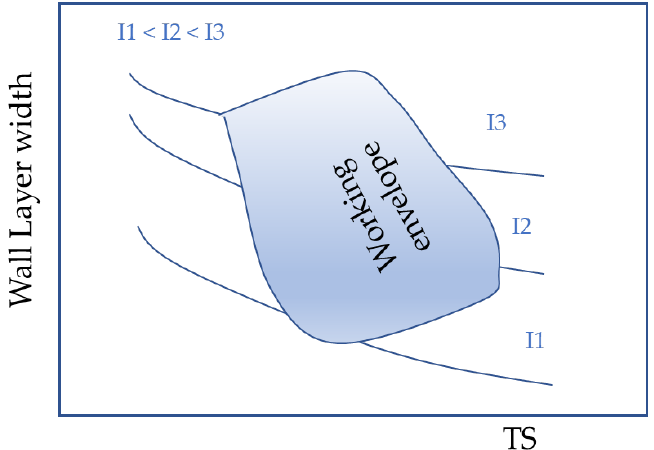
Figure 1. Schematic of an operational map and working envelope (workable range within the operational map) to be raised as the objective of this work.